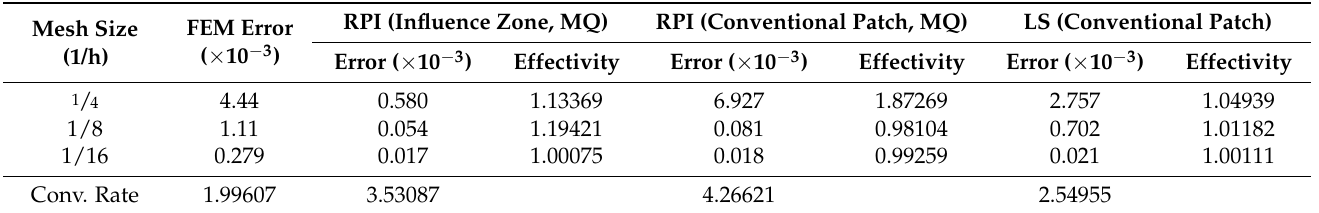
Table 3. Error properties results for LS- and RPI (MQ)-based recovery approach in incompressible- elastic plate analysis considering influence zones and conventional patches (four-node quadrilateral irregular mesh).